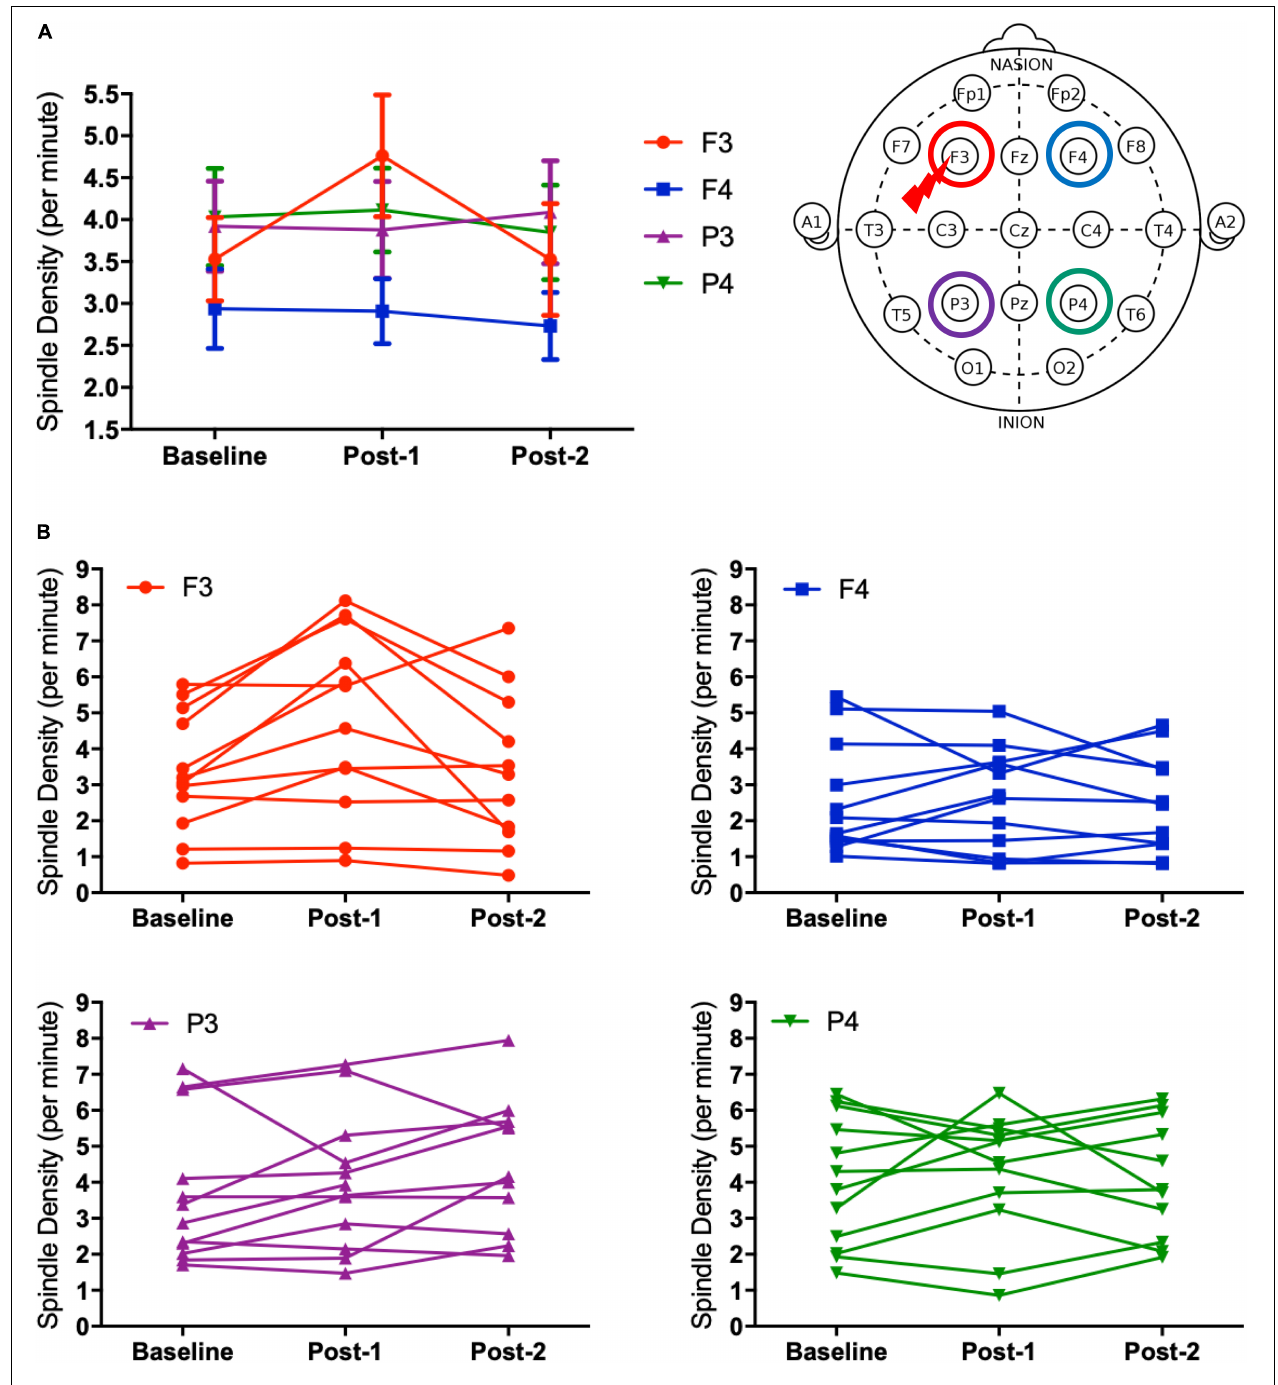
FIGURE 2 | Spindle density changes over time. (A) The graph at the left shows sleep spindle density, which is the number of spindles recorded per minute during NREM sleep Stages II–IV, from four derivations of F3, F4, P3, and P4. As illustrated at the right, the F3 electrode is closer to the stimulation site of rTMS sessions. Spindle density at F3 increased from Baseline to Post-1 ( P = 0.008) and then decreased from Post-1 to Post-2 ( P = 0.044). (B) Inter-individual differences in spindle density change over time. Individual data was presented in four figures of F3, F4, P3, and P4